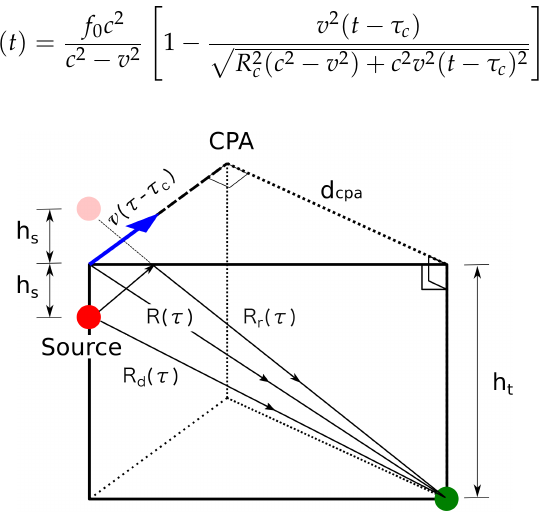
Figure 6. Lloyd's mirror destructive-interference